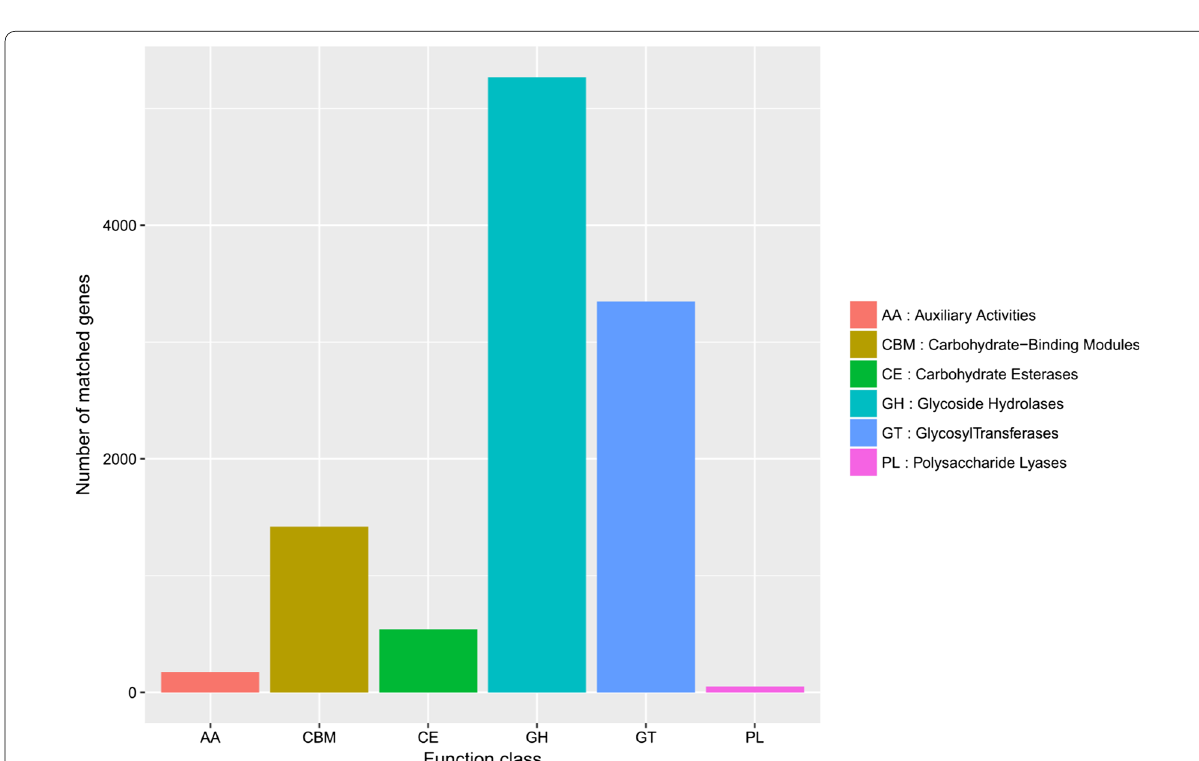
a network diagram of species associated with resistance genes was constructed (Fig.